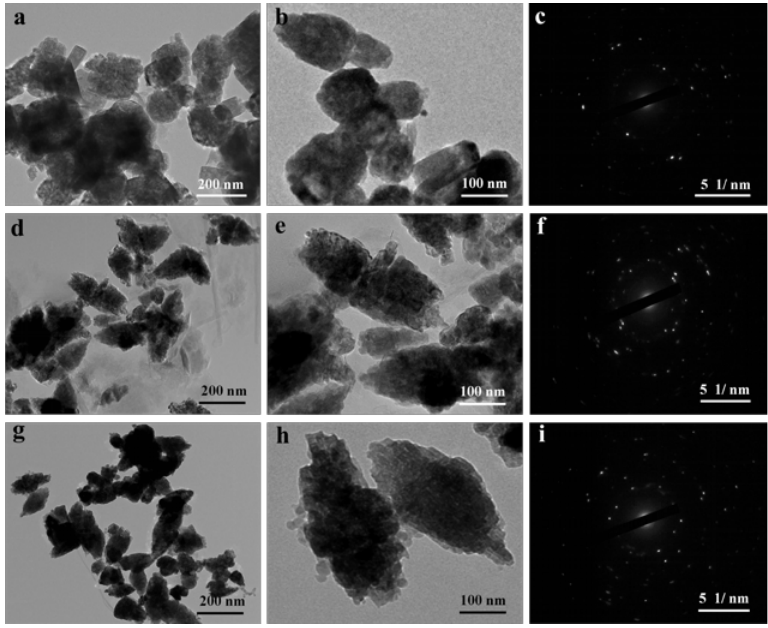
Figure 4. Transmission electron microscope (TEM) images and selected area electron diffraction pattern of ( a – c ) ZnO/PAL, ( d – f ) ZnO/PAL-1 and ( g – i ) ZnO/PAL-2.